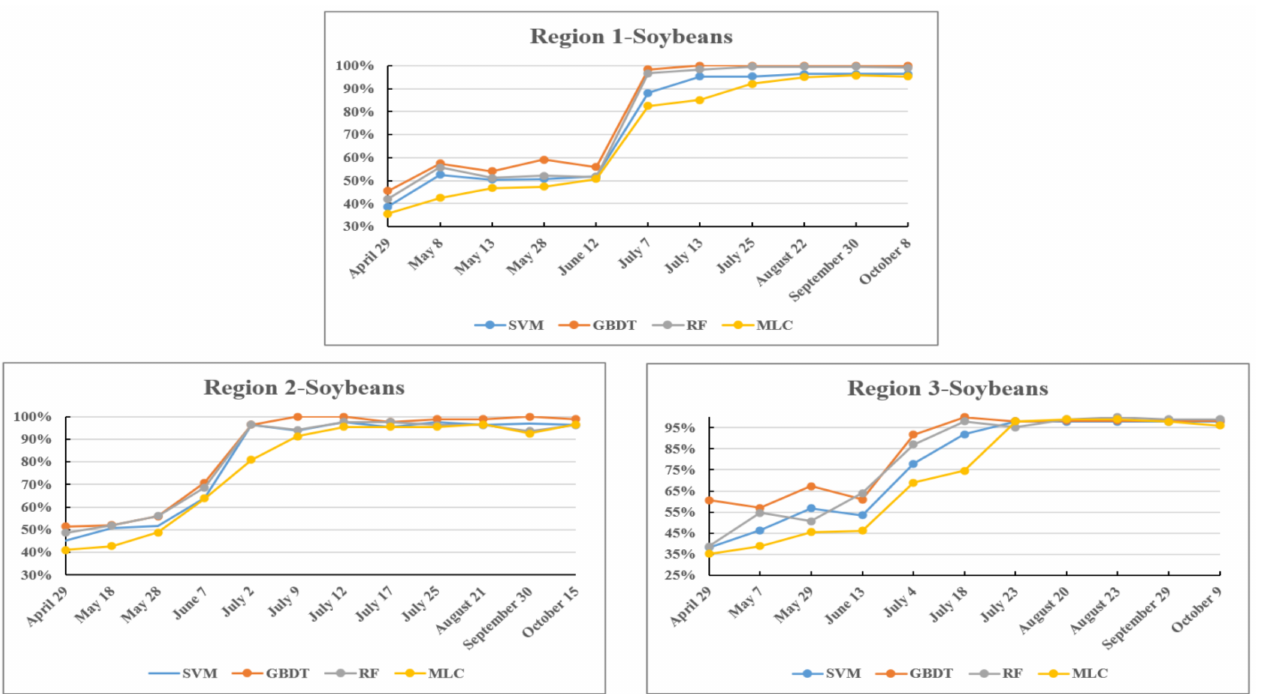
Figure 9. The recognition accuracy of soybeans in different periods in the three study areas.